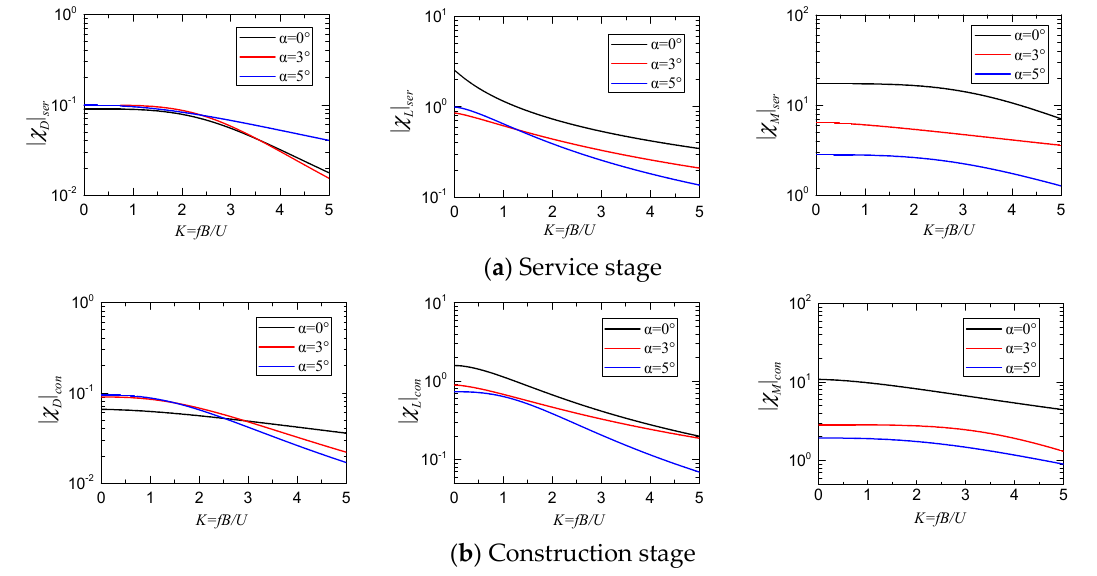
Figure 11. Fitted AAFs for the DDTG without the peak item in Equation (13).